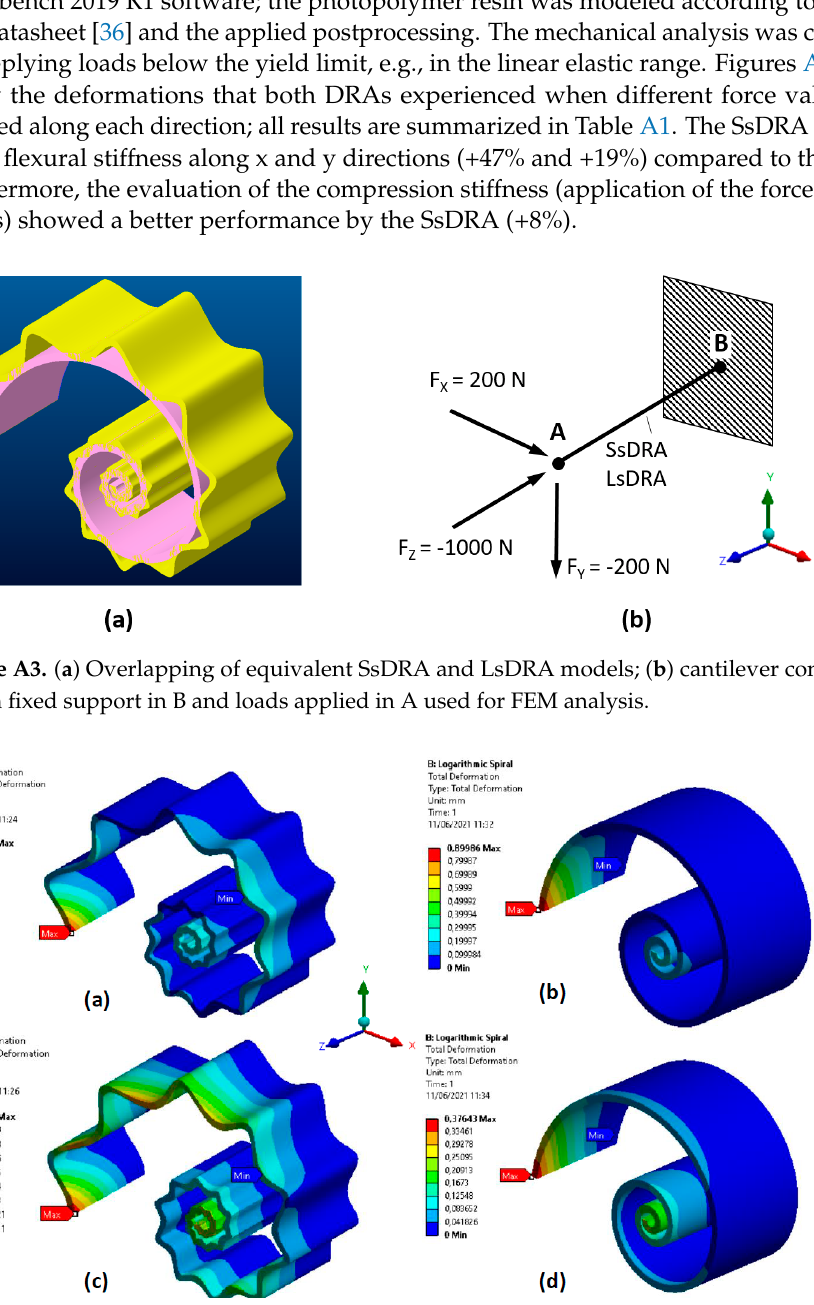
Figure A5. A comparison of the compression stiffness (upsetting) of the ( a ) SsDRA and ( b ) LsDRA: deformations under a load corresponding to Fz = − 1000 N; Fx = Fy = 0. Table A1. Summary of the FEM structural analysis of the SsDRA and LsDRA and related stiffnesses.